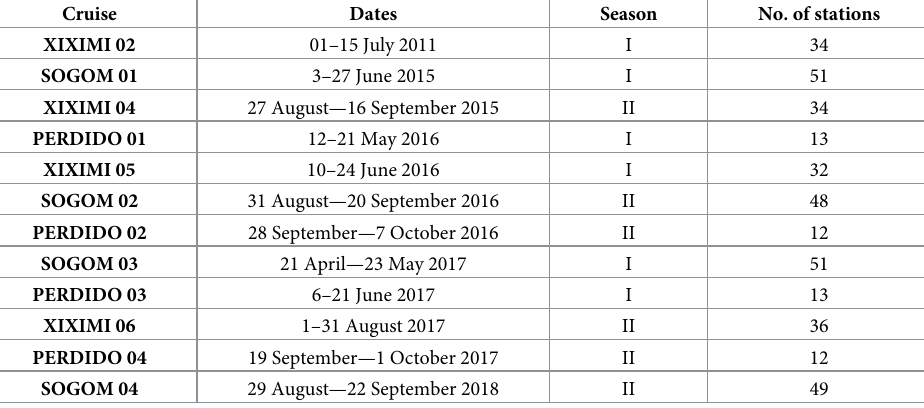
Table 1. Cruises in which larval fish sampling surveys were conducted presented in chronological order.